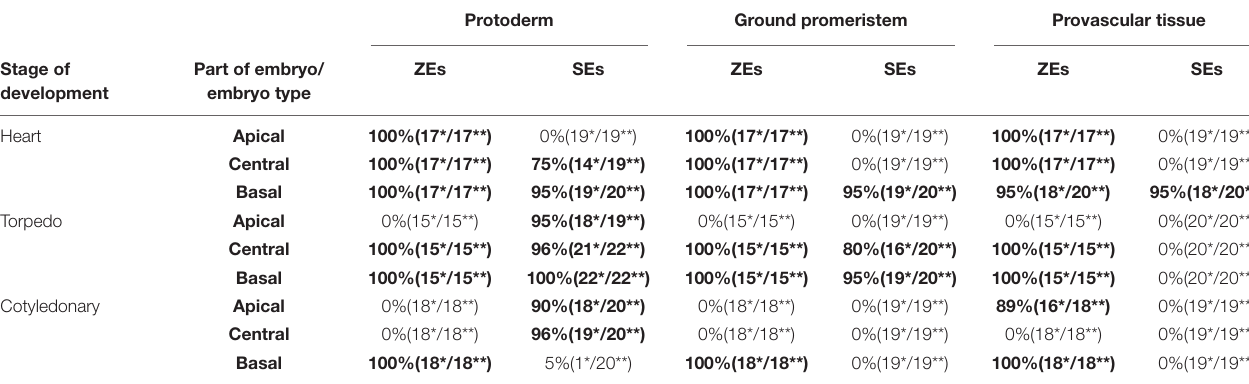
TABLE 4 | Comparison of the movement frequency of the GFP in ZEs and SEs of the Arabidopsis thaliana AtSUC3:GFP transgenic line.